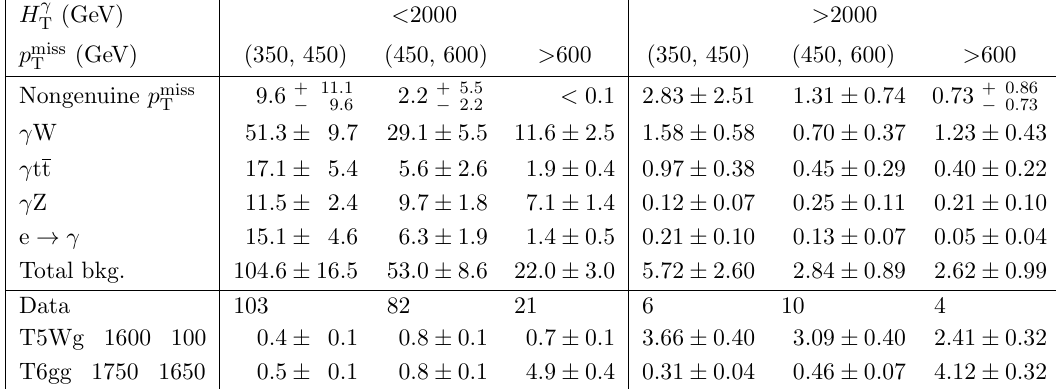
Table 1 . Observed data compared to the background prediction and the expected signal yields for two signal scenarios. The expectations are given for the T5Wg signal scenario with a gluino mass of 1600 GeV and a gaugino mass of 100 GeV and the T6gg signal scenario with a squark mass of 1750 GeV and a neutralino mass of 1650 GeV. The quadratic sum of statistical and systematical uncertainties is given. Only experimental uncertainties for the signal model are stated.